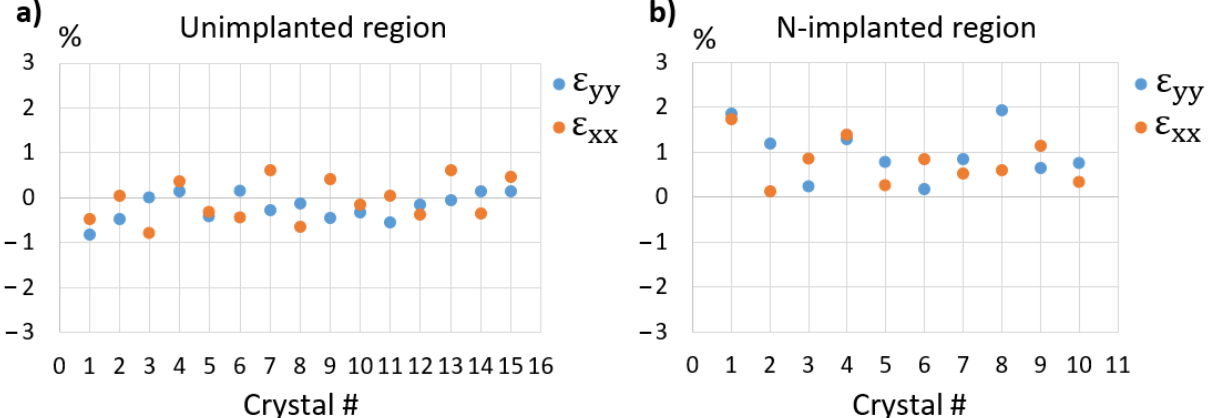
Figure 7. Strain components (ε xx , ε yy ) extracted from 15 large crystals in the unimplanted region ( a ) and 10 smaller crystals in the N-implanted region ( b ). The specimen was annealed at 210 °C for 30 min to initiate crystallization.